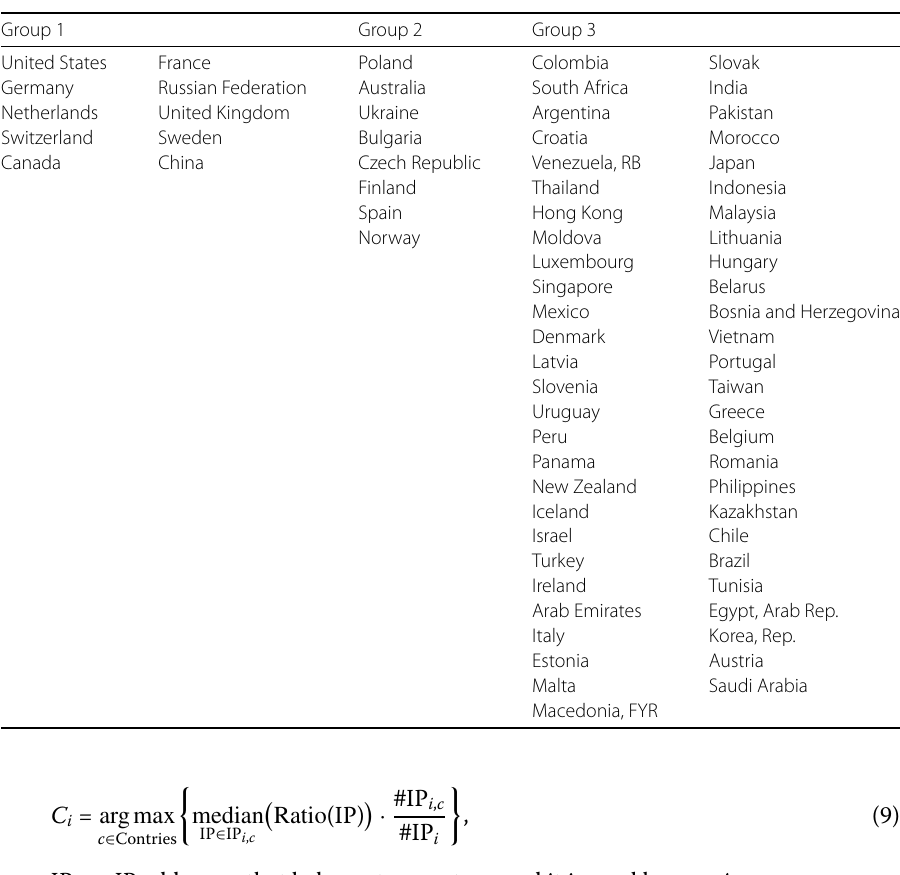
Table 9 Selected countries for this work. Moreover, as done for the visualization in Fig. 7 the countries are divided in three groups based on the sum of amount sent and received Group